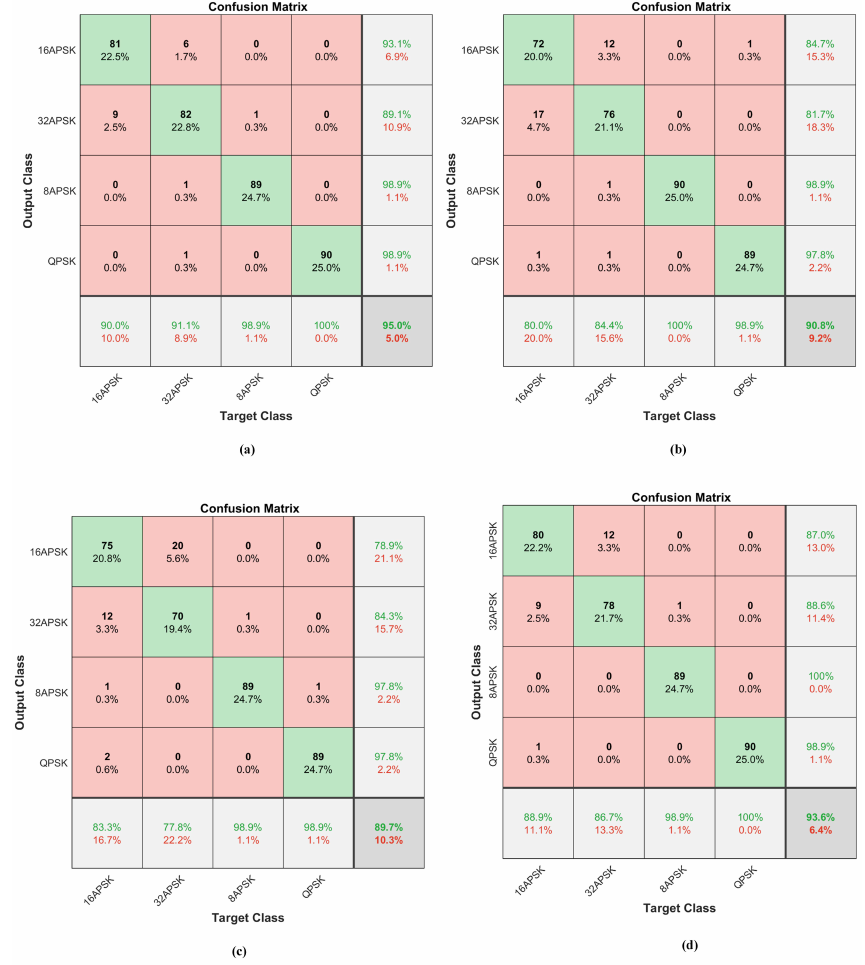
Figure 6. AMC result in the presence of SoI (AMC1) using ( a ) AlexNet (95%), ( b ) VGG16 (90.08%), ( c ) GoogleNet (89.7%), and ( d ) ResNet18